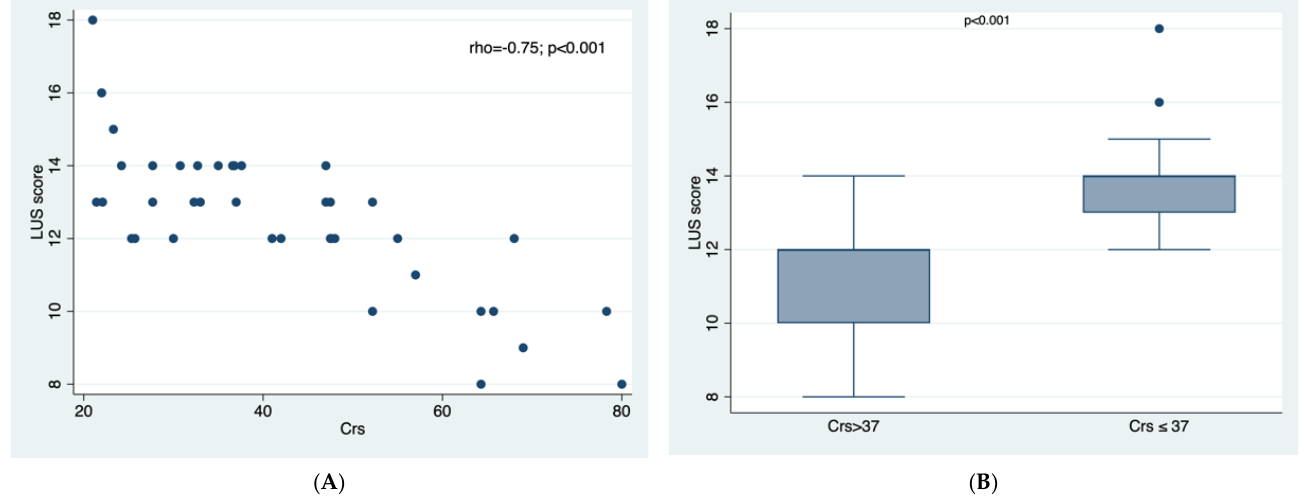
Figure 1. Figures representing the relationships between LUS score and static compliance (Crs). ( A ). LUS score and Crs are inversely correlated, the higher the LUS, the lower the Crs. ( B ). Low compliance group (Crs ≤ 37) has been found to be associated with the highest LUS scores. of clot strength from fibrin (Figure 2A). Among 18 patients with LUS score ≤ 12, median FF- MA (range of normal values: 15–32 mm) was 31 mm [IQR 28–39], whilst among 22 patients with LUS score > 12, median FF-MA was 46.3 mm [IQR 40–53], p = 0.0004 (Table 1 and Figure 2A). There was also a significant but moderate association between Crs and FF-MA, p = 0.03 (Figure 2B).